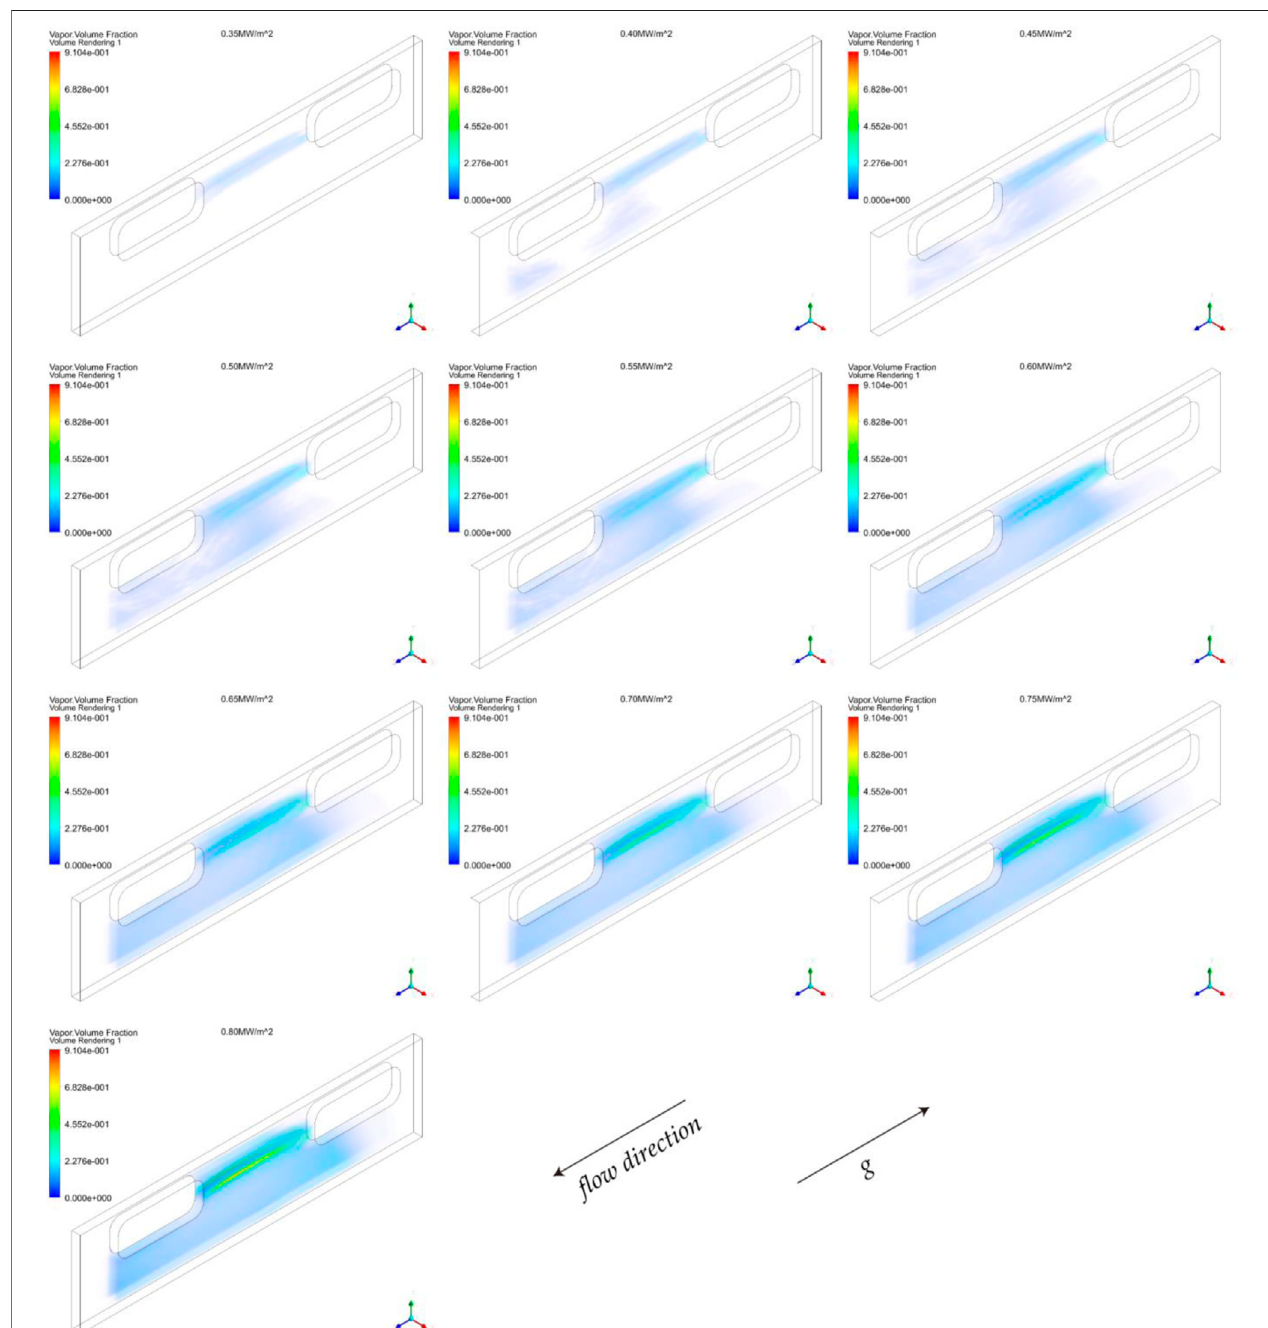
FIGURE 10 | Void fraction in channel with pillow-like